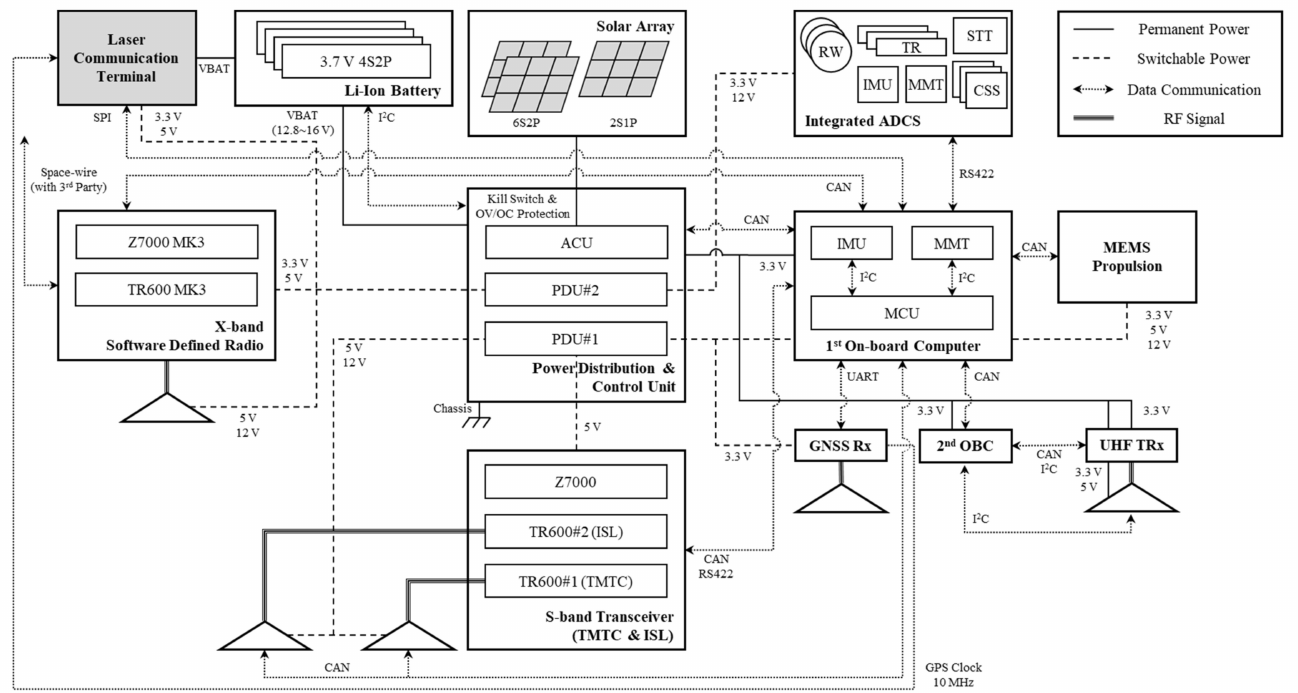
Figure 15. Diagram of the electrical interface for the nanosatellite bus. Except the primary OBC and redundancy systems, all power supplies are switchable with latch-up protections. Data communica- tions are mainly implemented by CAN